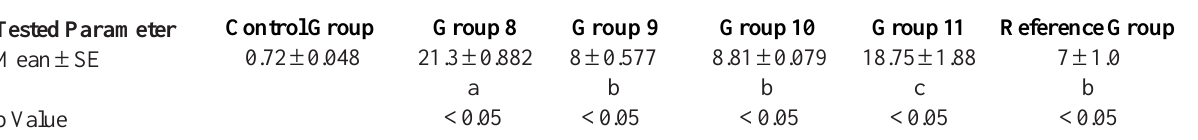
Table 3 – Mean free serum testosterone level (pg/mL) among groups of rats treated with different fractions of 70% alcoholic extract of fruits of Tribulus